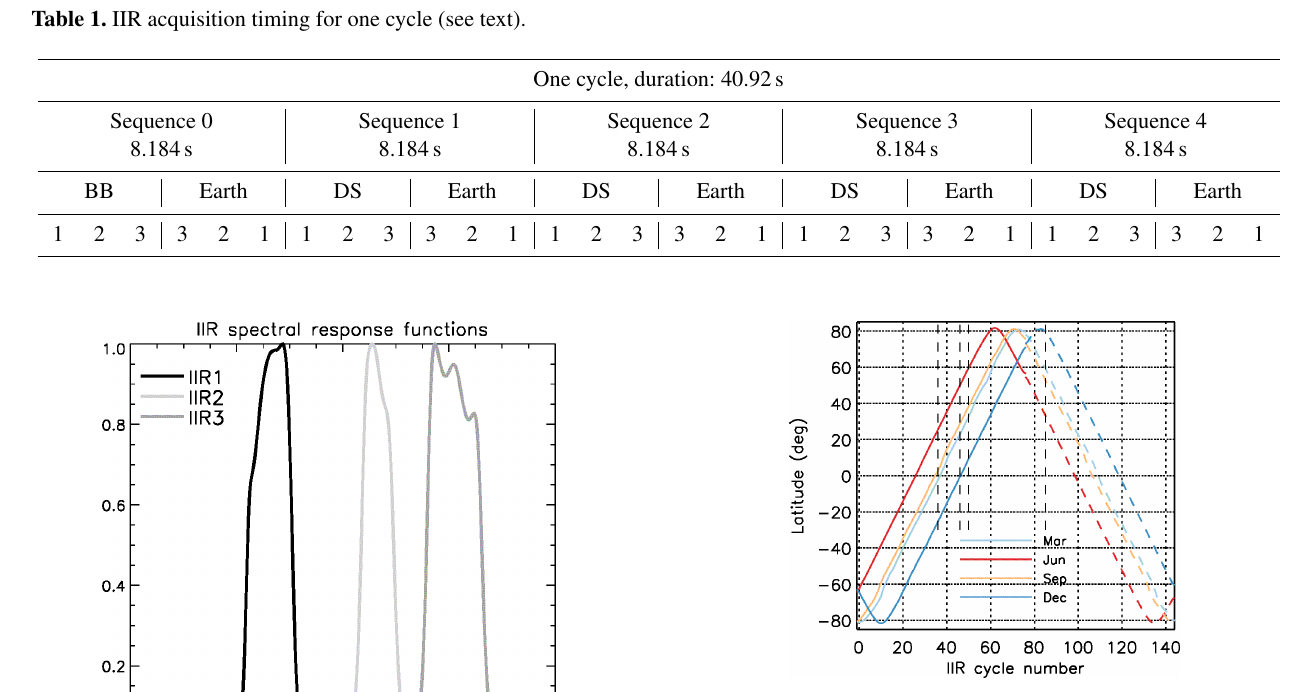
Figure 2. Relationship between IIR cycle number and latitude in March (light blue), June (red), September (orange), and December (dark blue). Solid: day; dashed: